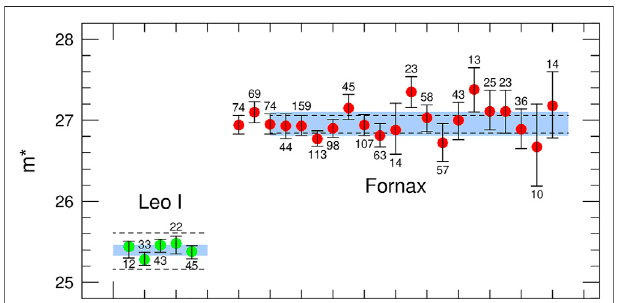
FIGURE 3 | Measured values of m * in the galaxies of the Leo I group (Ciardullo et al., 1989a; Feldmeier et al., 1997; Ciardullo et al., 2002a) and the Fornaxcluster(Spriggsetal.,2021).InLeoI,thegalaxiesaresortedbyHubble type, goingfromSbonthelefttoE0ontheright.TheFornaxclusterdata are given in order of the galaxies ’ Wise W1 magnitudes (brightest galaxies on the left) and span a range of over 4.5 mag. Immediately below or above each point are the number of PNe used in the PNLF fi t; for Leo I galaxies, this numberonlyincludesobjectsabovethe90%completenesslimit;inFornax,all the PN detected in a galaxy were used in the solution. The light blue shading shows the 1 σ dispersion in the distribution of the best- fi t values, and the dotted lines indicate a distance of ±1Mpc from the mean value. The errors bars represent the uncertainties in the individual measurements, and are largely driven by the number of PNe in the top ~ 0 . 5 mag of the luminosity function. There is no indication that m * depends on any galaxy property.